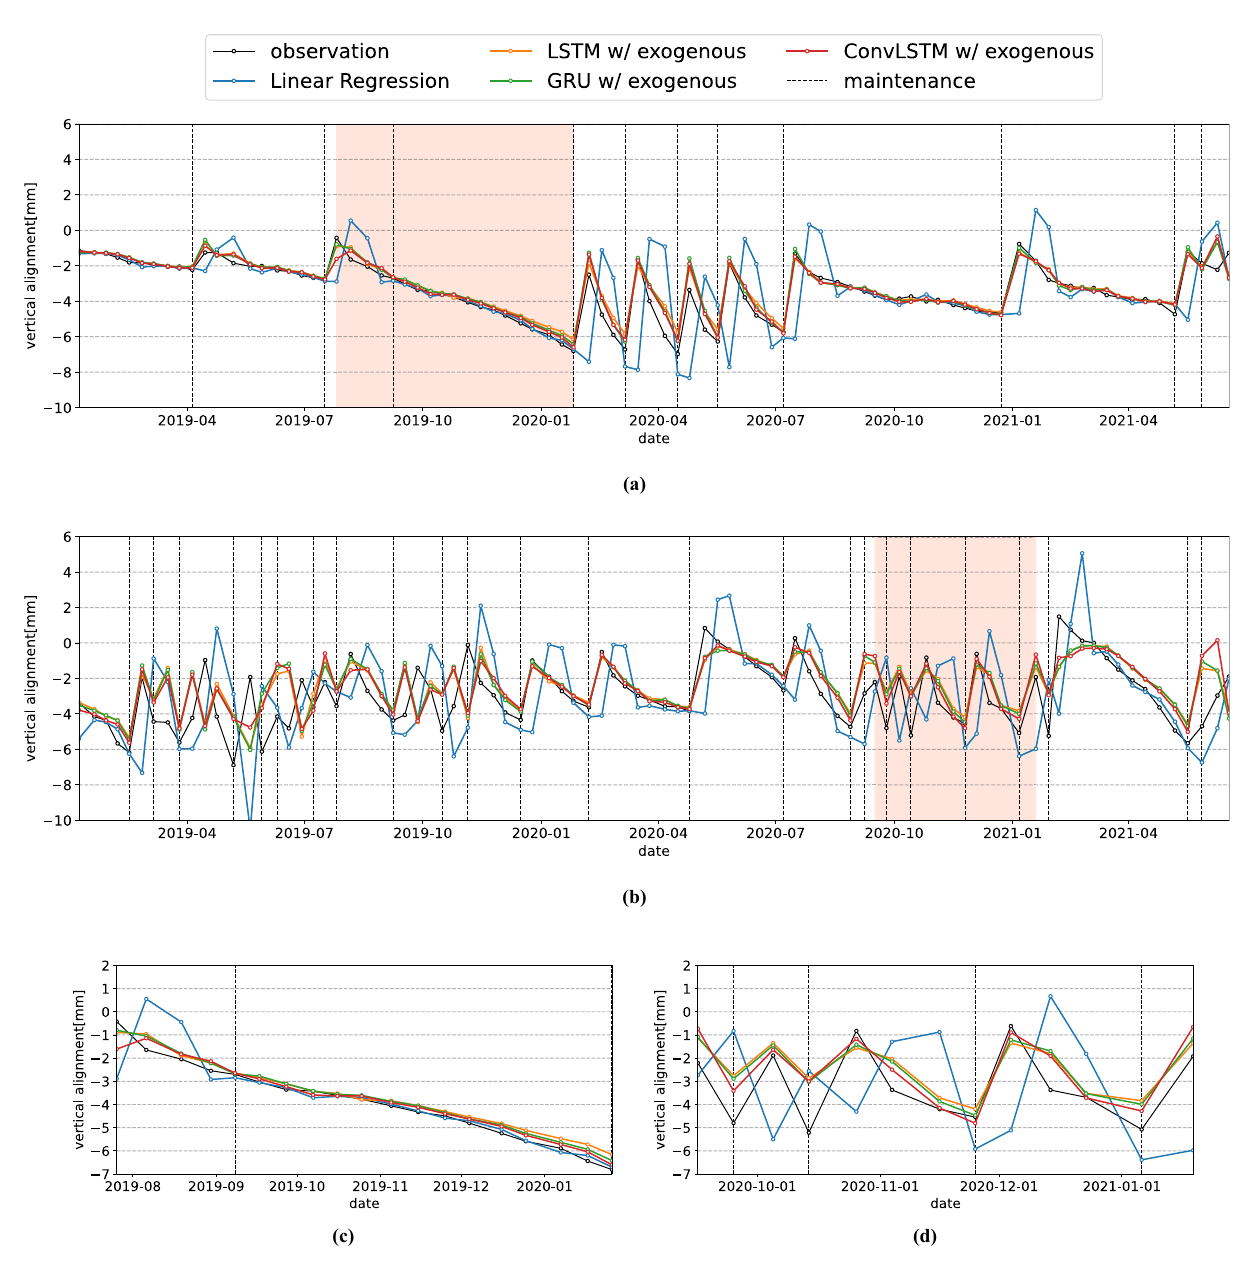
Figure 4. Forecasted time series of specific spatial points for each method. The vertical dotted lines indicate the dates when maintenance operations were performed. ( a ) is the time series of a specific spatial point with a normal maintenance frequency. ( c ) is the orange part of ( a ). ( b ) is the time series of a specific spatial point with a high maintenance frequency. ( d ) is the orange part of ( b